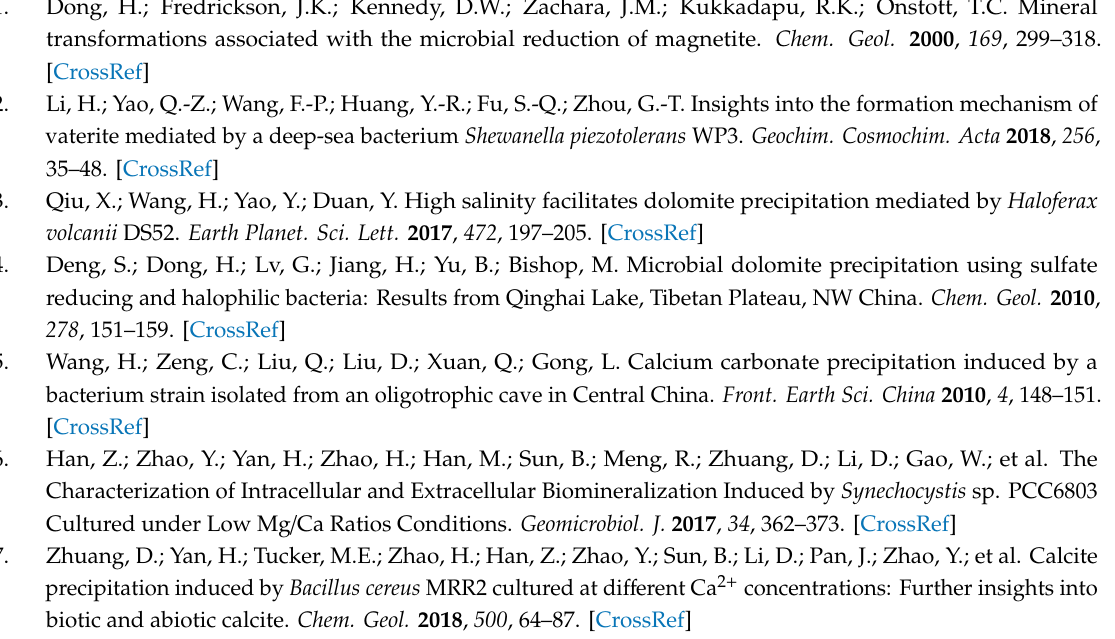
Table S1: Parameter settings of molecular dynamic simulation for adsorption of Glu onto various struvite surfaces, Table S2: Physiological and biochemical identification of ZW123 and Citrobacter freundii species, Figure S1: Phylogenetic tree of Citrobacter freundii ZW123 based on the sequence alignment, Figure S2: SEM image of Citrobacter freundii ZW123 bacteria (a) and Gram staining test (b) and NH3 test (c: before adding the Nessler’s reagent; d: after adding the Nessler’s reagent. 1, control group; 2 and 3, experimental groups), Figure S3: Rietveld refinement of XRD data at Mg / Ca molar ratio 0 (a), 3 (b), 6 (c), 9 (d) and 12 (e), Figure S4: Molecular dynamics simulation of adsorption of Glu onto crystal: a: temperature fluctuation of the adsorption of Glu onto (111) faces, b: energy fluctuation of the adsorption of Glu onto (111)